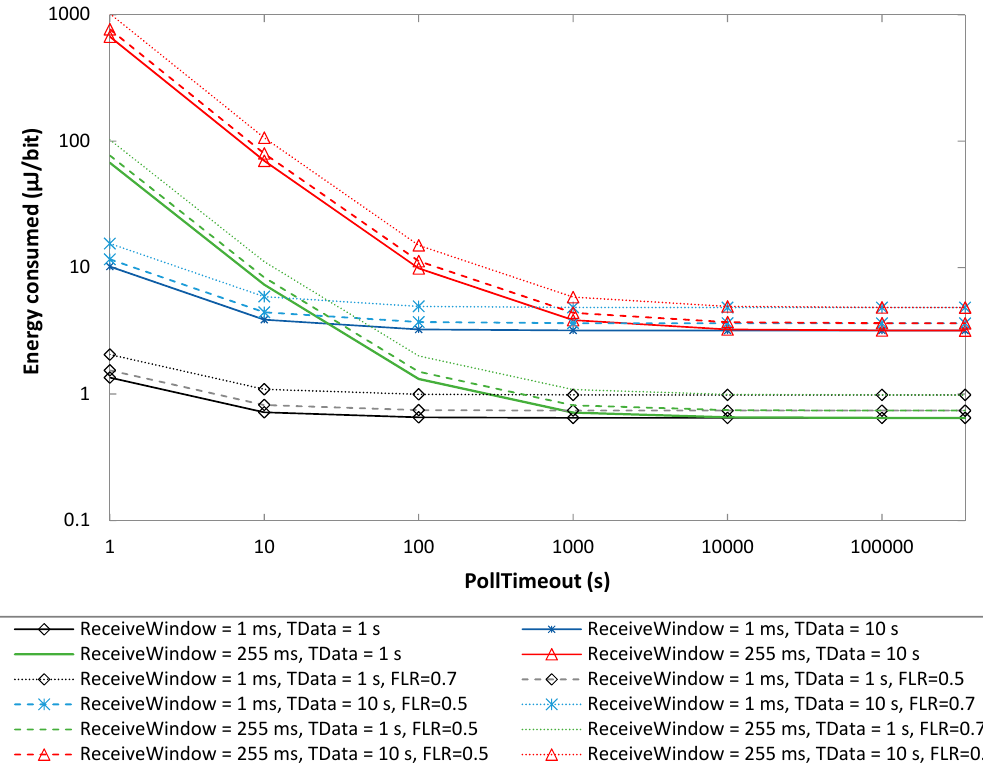
Figure 12. Energy consumed per delivered data bit, as a function of PollTimeout, for different ReceiveWindow, T Data and FLR values.